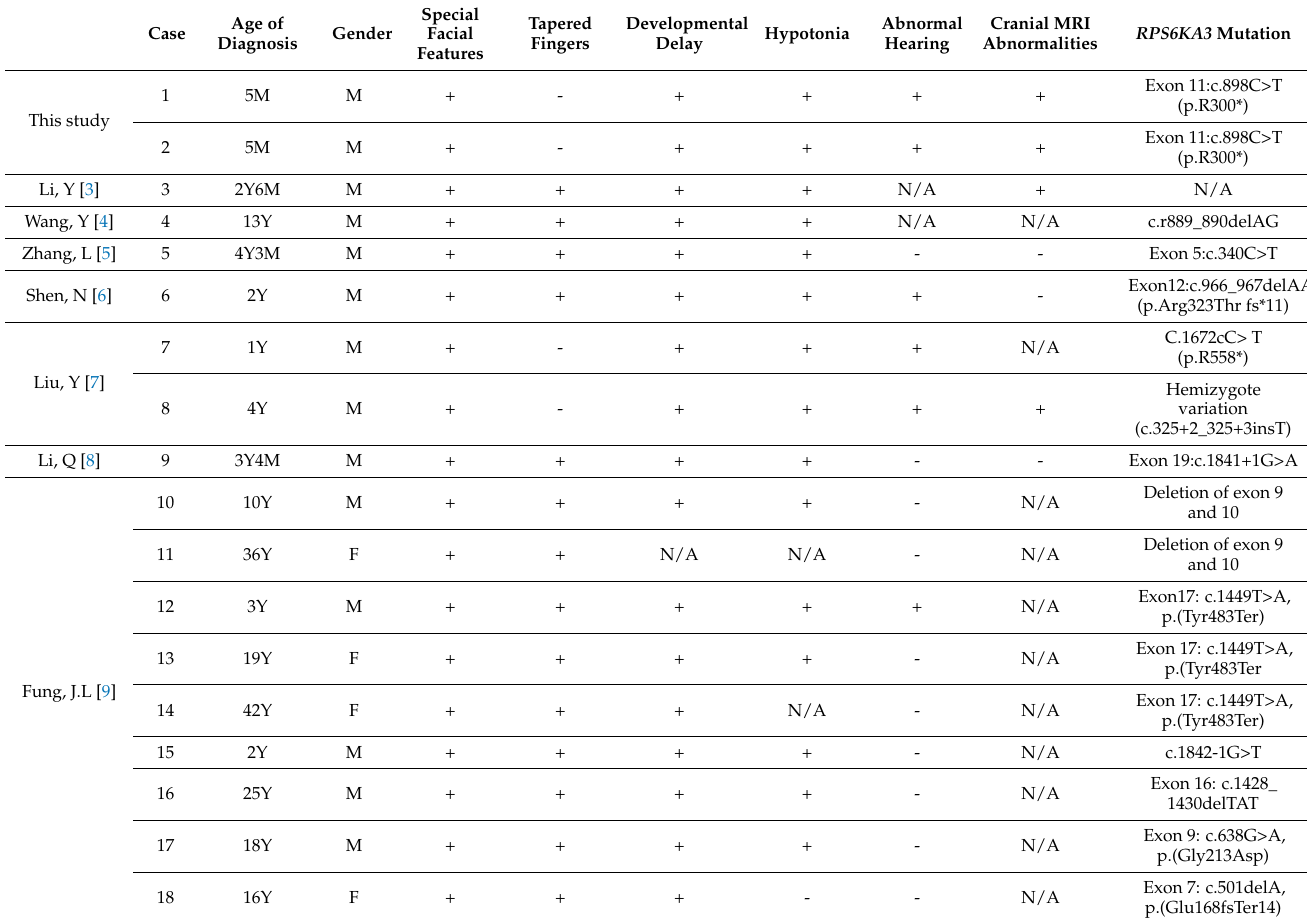
Table 4. The phenotypic and genetic characteristics of GLS in